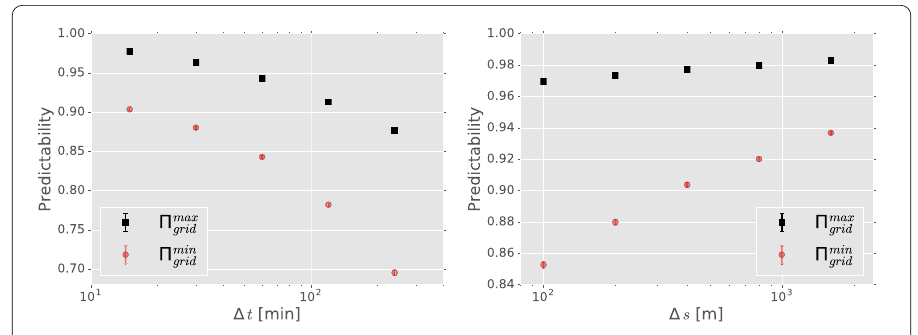
Figure 4 Nextbin predictability depends on spatiotemporal resolution. Left panel: The temporal resolution dependency of the upper limits (squares) and lower limits (discs) of predictability for the next bin approach. Each location is represented by a square grid with (cid:3) s = 400 m. Error bars are included but are smaller than the symbols. Right panel: The spatial dependency at a fixed temporal resolution of (cid:3) t = 15 min. The lower limit shows that, depending on resolution, 85% to 94% of the predictability is due to people not moving.